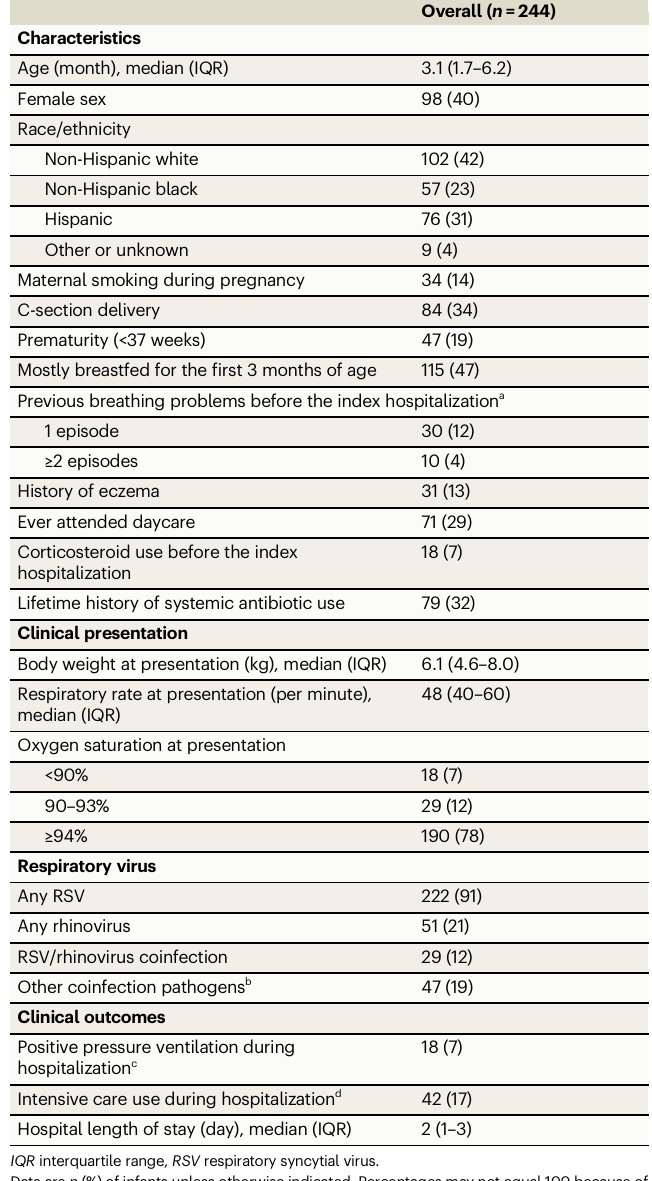
Table 1 | Patient characteristics of 244 infants hospitalized for